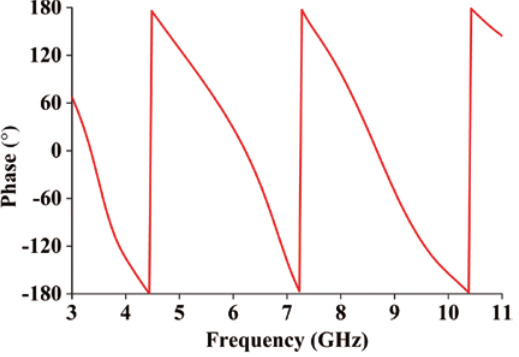
Figure 3: Phase variation of the proposed antenna.